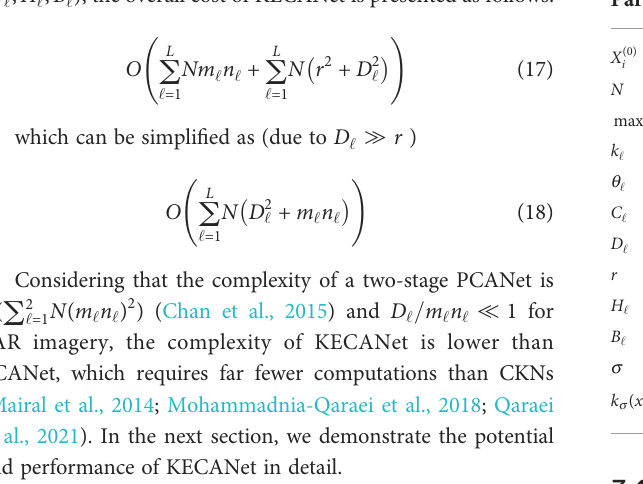
TABLE 1 KECANet parameter con fi guration for the TenGeoP-SARwv database.